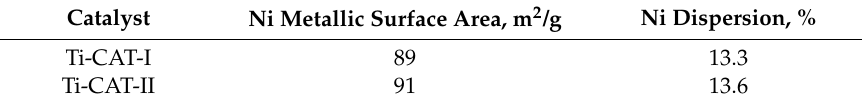
Table 3. Ni metallic surface area and dispersion obtained by H 2 chemisorption.